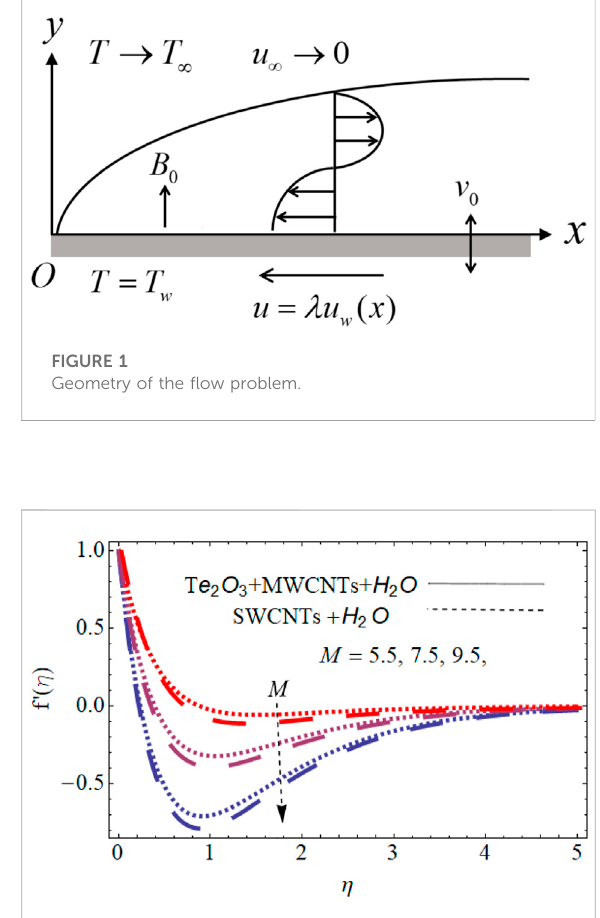
FIGURE 2 Inspiration of the magnetic fi eld parameter on velocity pro fi